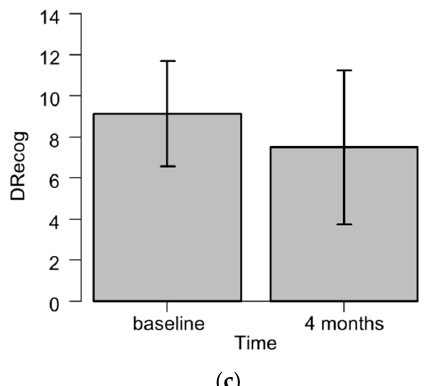
Figure 1. The Hopkins Verbal Learning Test-Revised (HVLT-R) total recall (TR) ( a ); delayed recall (DR) ( b ); and delayed recognition (DRecog) ( c ) scores of the patients who underwent the examination at the baseline and four months after WBRT ( n = 16). The raw scores are indicated as mean ± SD. * p < 0.01 by Wilcoxon signed rank test.